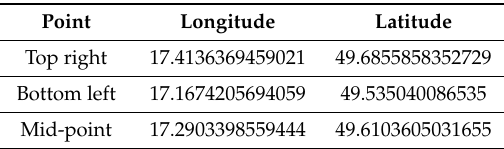
Table 4. Bounding box for the Olomouc area.